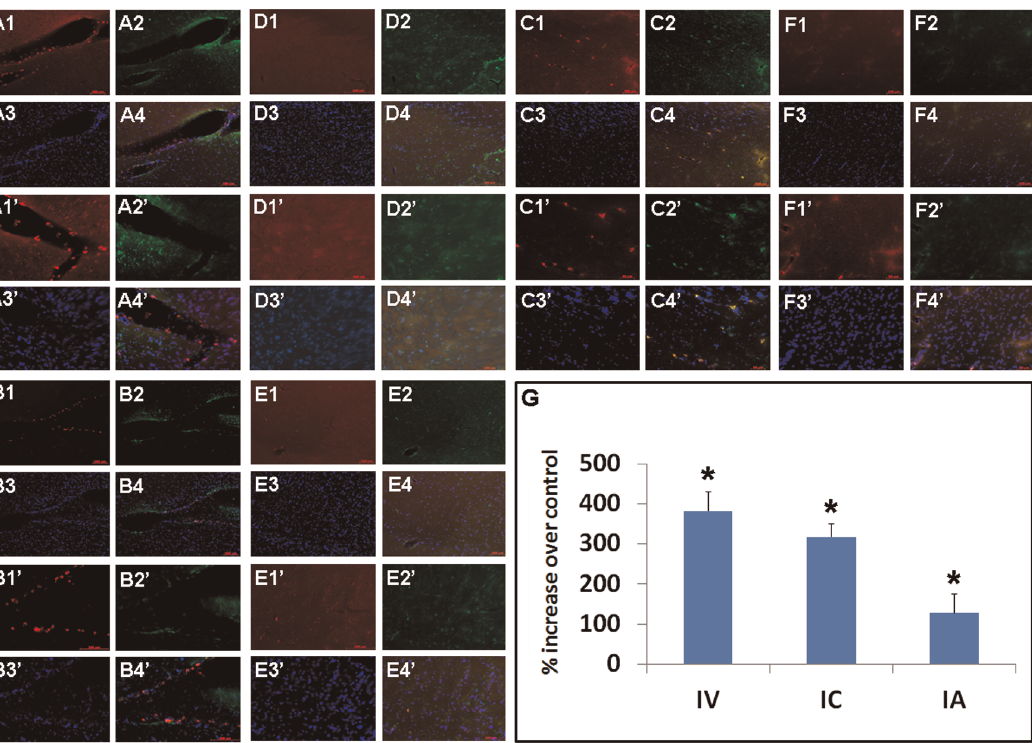
Figure 6. DPC grafts within the peri-infarct area co-localize with Hsp27 expression. The majority of grafted DPCs were deposited within the ipsilateral peri-infarct striatal site as detected by the fluorescent dye tracker PKH26. Less than 1% of the grafts survived with no detectable differences in graft persistence whether delivered IV, IC, or IA (p . 0.05). Only sparse PKH26-labeled cells were found in the contralateral intact hemisphere across all three delivery routes. Significantly increased Hsp27 expression was juxtaposed to grafted DPCs and quantitative analyses of Hsp27 expression (G) in the peri-infarct striatal site revealed robust Hsp27 expression in transplanted brains compared to controls, more pronounced in IV- and IC-delivered DPCs compared to IA-administered DPCs (*p , 0.05 vs. controls). A: IV-delivered cells, ipsilateral; B: IC-delivered cells, ipsilateral; C: IA-delivered cells, ipsilateral; D: IV-delivered cells, contralateral; E: IC-delivered cells, contralateral; F: IA-delivered cells, contralateral; 1: PKH26; 2: Hsp27; 3: DAPI; 4: Merged. 1–4: 10X; 1 9 –4 9 :20 6 .